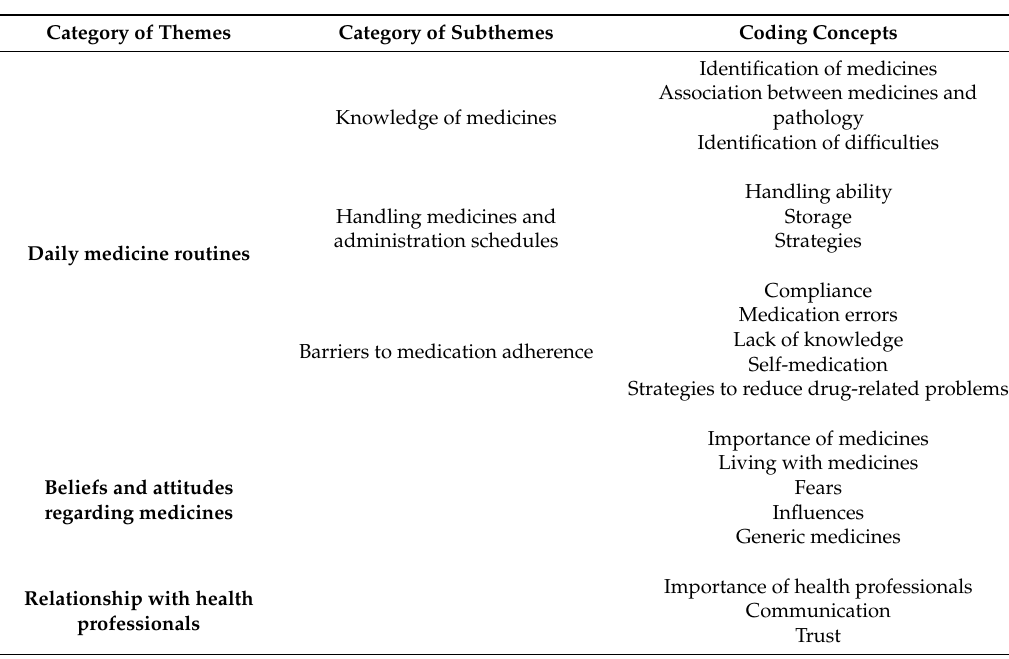
Table 3. Major themes from focus